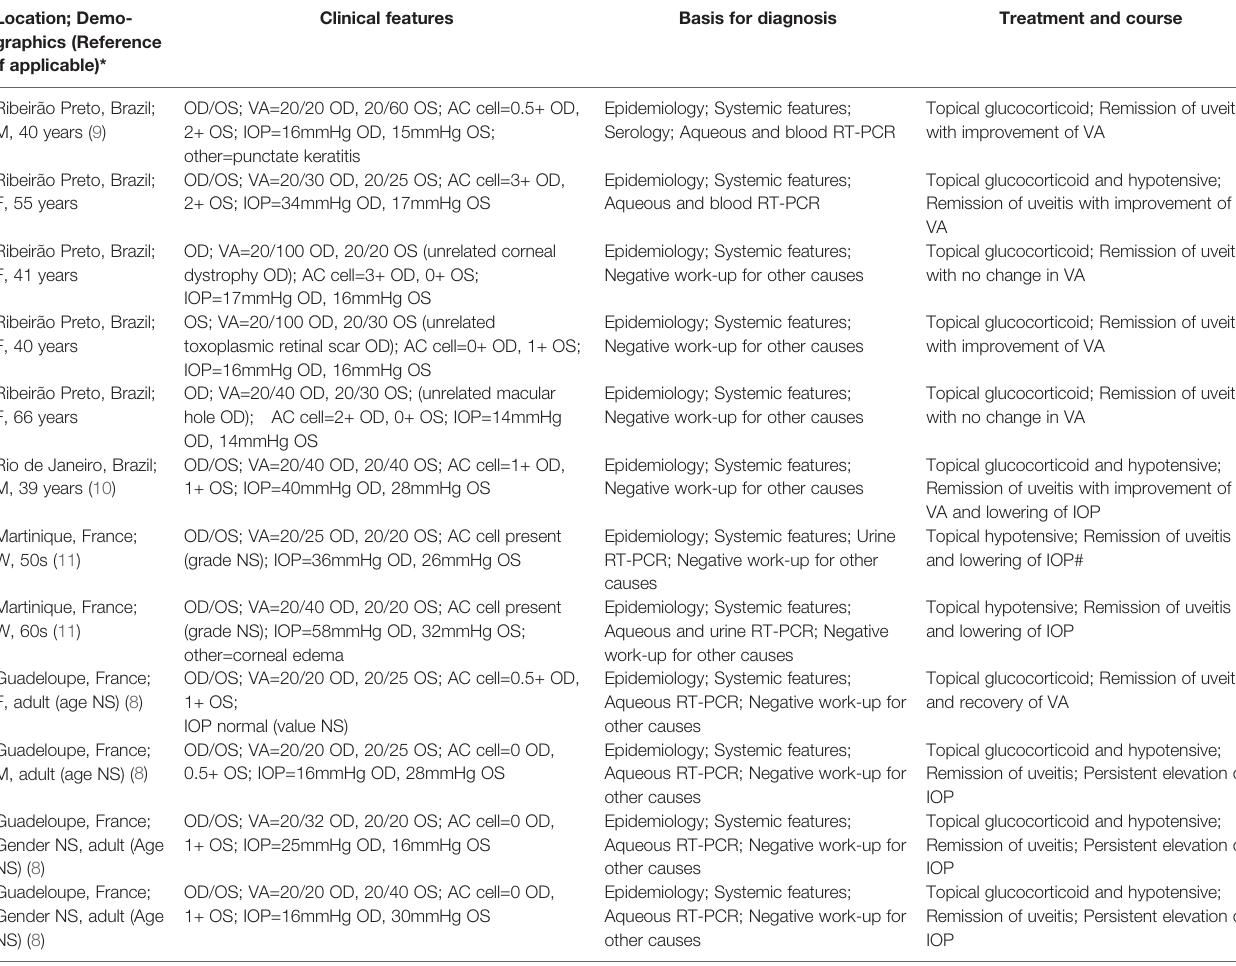
TABLE 1 | Clinical features of ZIKV-associated anterior uveitis diagnosed in patients presenting to the Ophthalmology Clinic of Ribeirão Preto General Hospital, Ribeirão Preto, São Paulo or reported in the medical literature. Location; Demo- graphics